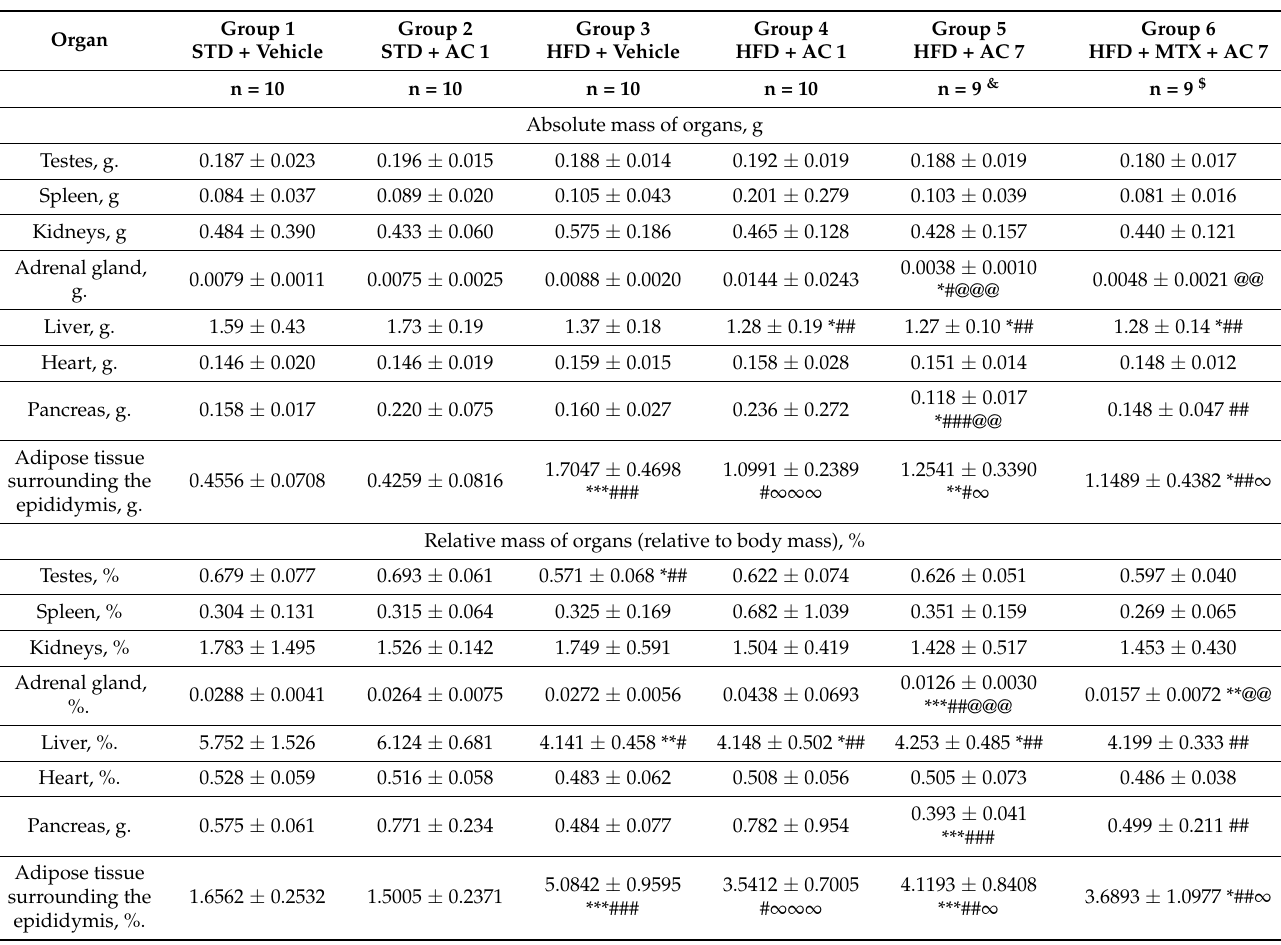
Table 10. Organ mass in